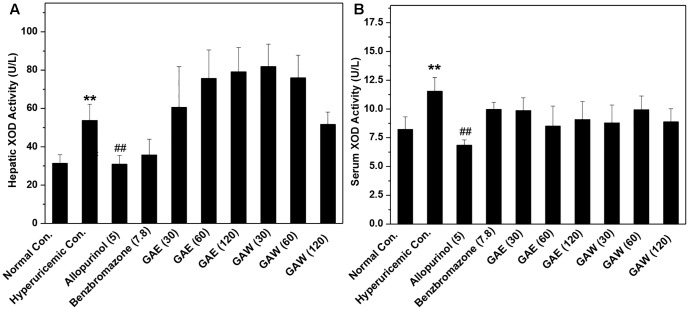
Effects of G. applanatum extracts on XOD activities in the liver (A) and serum (B) in mice. ∗∗P < 0.01 as compared to the normal control; ##P < 0.01 as compared to the hyperuricemia control.